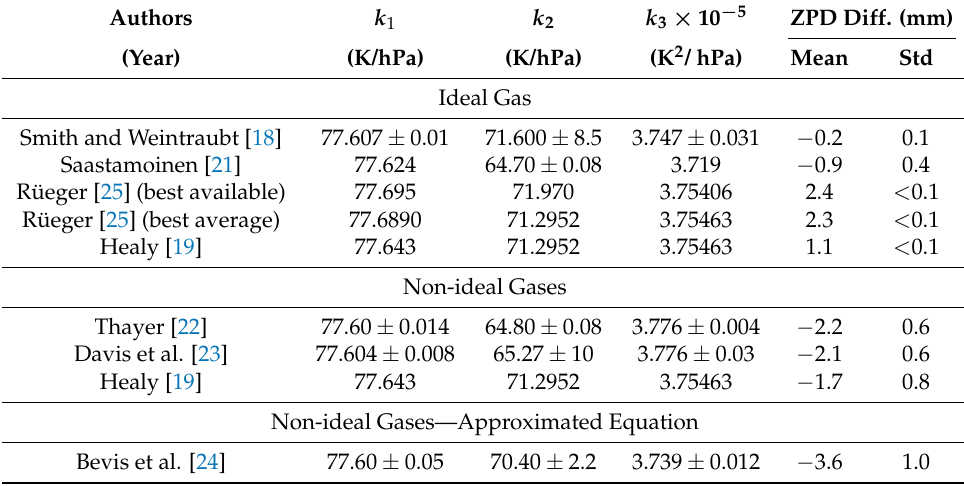
Table 1. Summary of the coefficient constants k 1 , k 2 and k 3 from [18,19,21–25]. They are divided into three groups: (1) ideal gases; (2) non-ideal gases; (3) non-ideal gases based on an approximated equation. Differences relative to the reference ZPD ( L atmo , approx with rounded coefficient constants [18]) are calculated for NWP products during August 2013 at the Wettzell GNSS station. The mean value and the standard deviation of the differences are